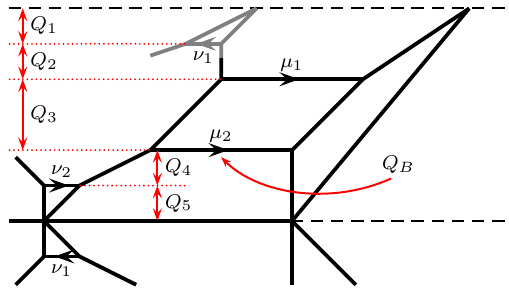
Figure 15. A brane web of SU(3) theory with Z 2 twist coupled with two